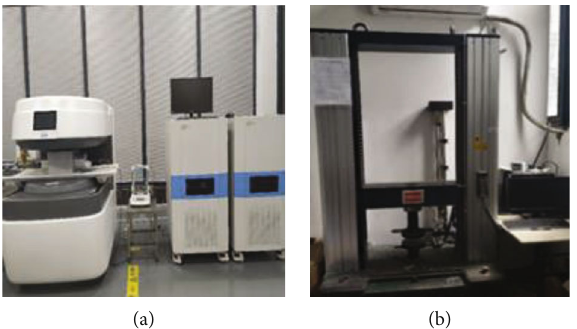
Figure 2: Main experimental equipment: (a) low-temperature and high-pressure nuclear magnetic resonance spectrometer; (b) UTM5540 electronic universal testing